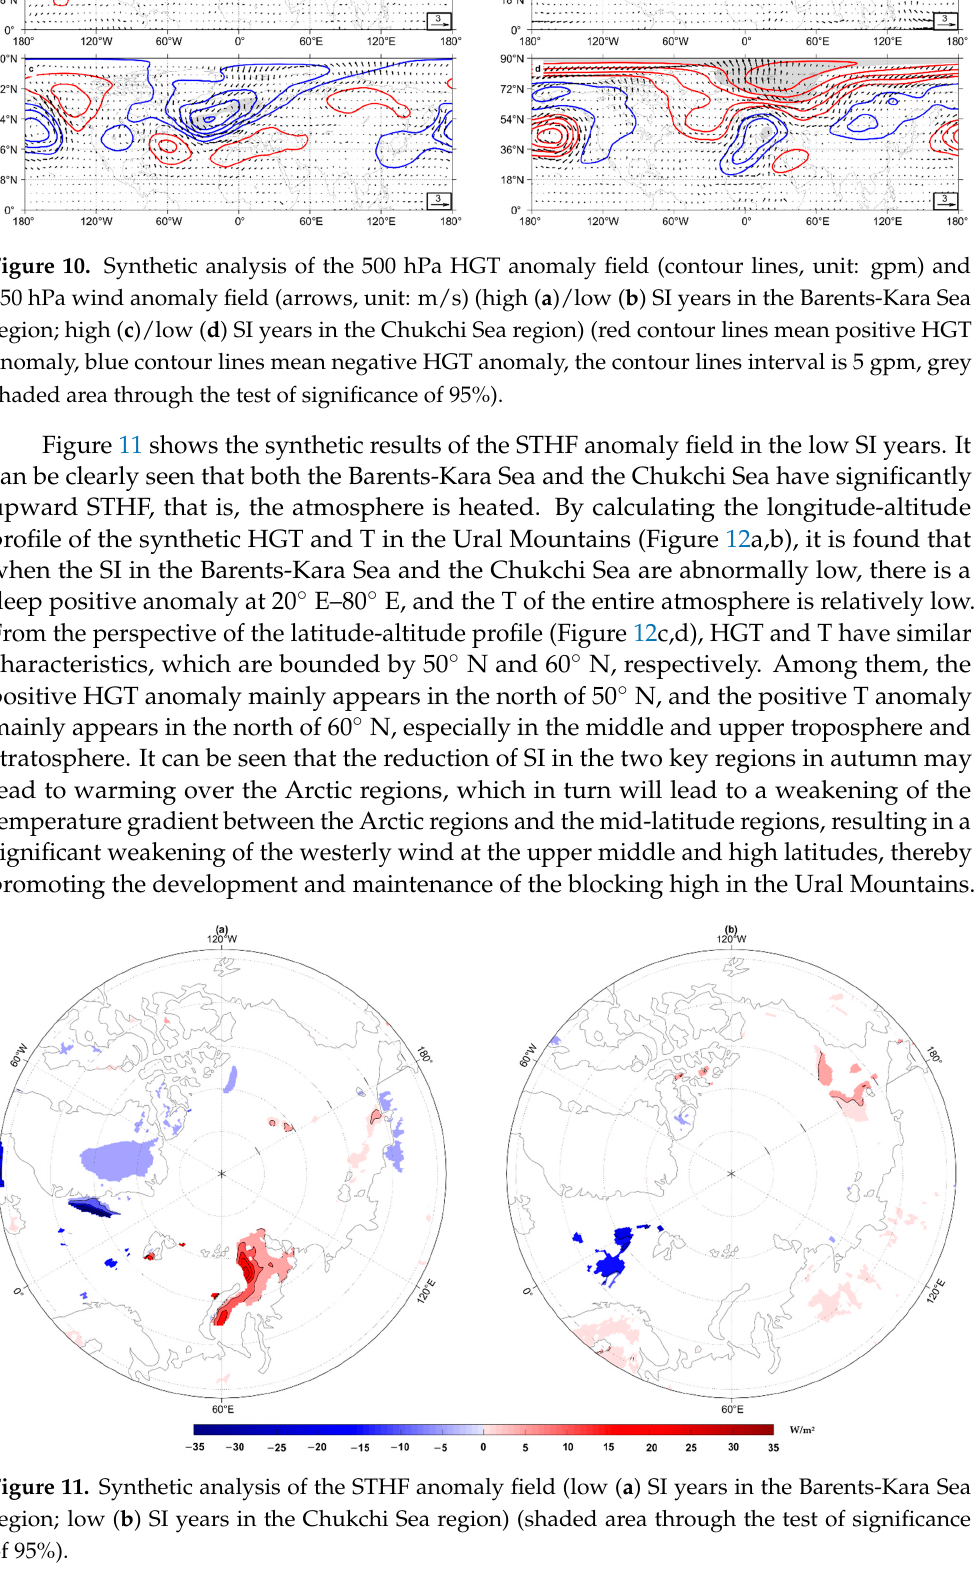
Figure 9. The correlation coefficient between the UBHI in extended winter and SI throughout the four seasons mean (( a ): spring; ( b ): summer; ( c ): autumn; ( d ): winter) and annual mean ( e ) (red shaded area means positive correlation coefficient, blue shaded area means negative correlation co- efficient, the absolute value of the correlation coefficient of shaded area is greater than 0.3 and through the test of significance of 95%).